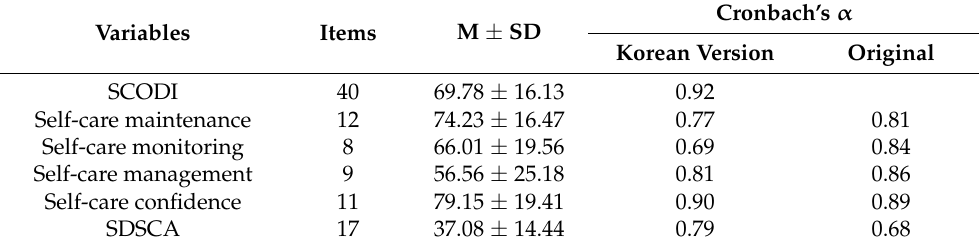
Table 5. Reliability of SCODI-K ( N =